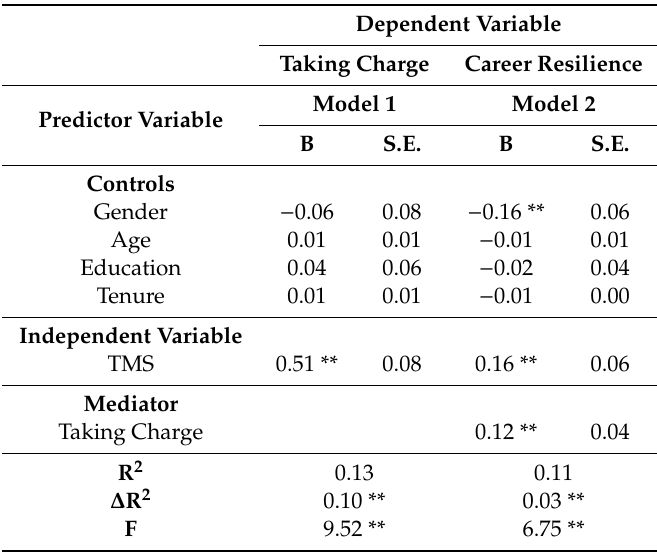
Table 4. Regression results for testing the mediation e ff ect.